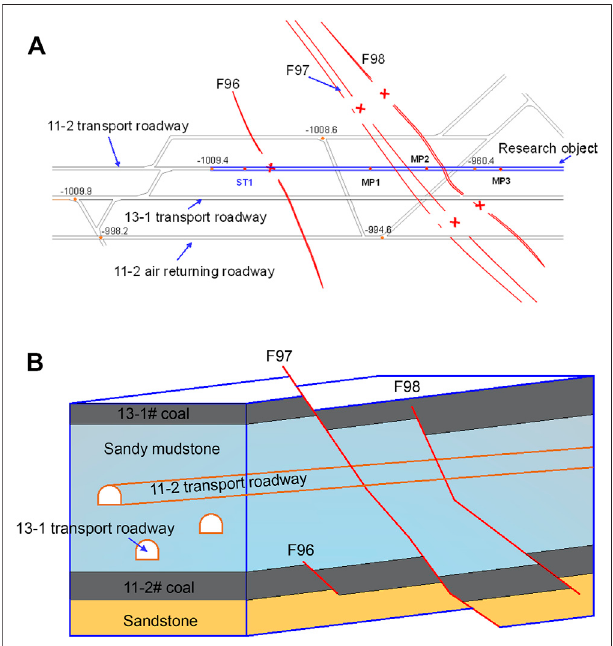
FIGURE 1 | Location and geology engineering environment of research object. (A) Locationofthe11-2transportroadway. (B) Geologicalstructure of the 11-2 transport